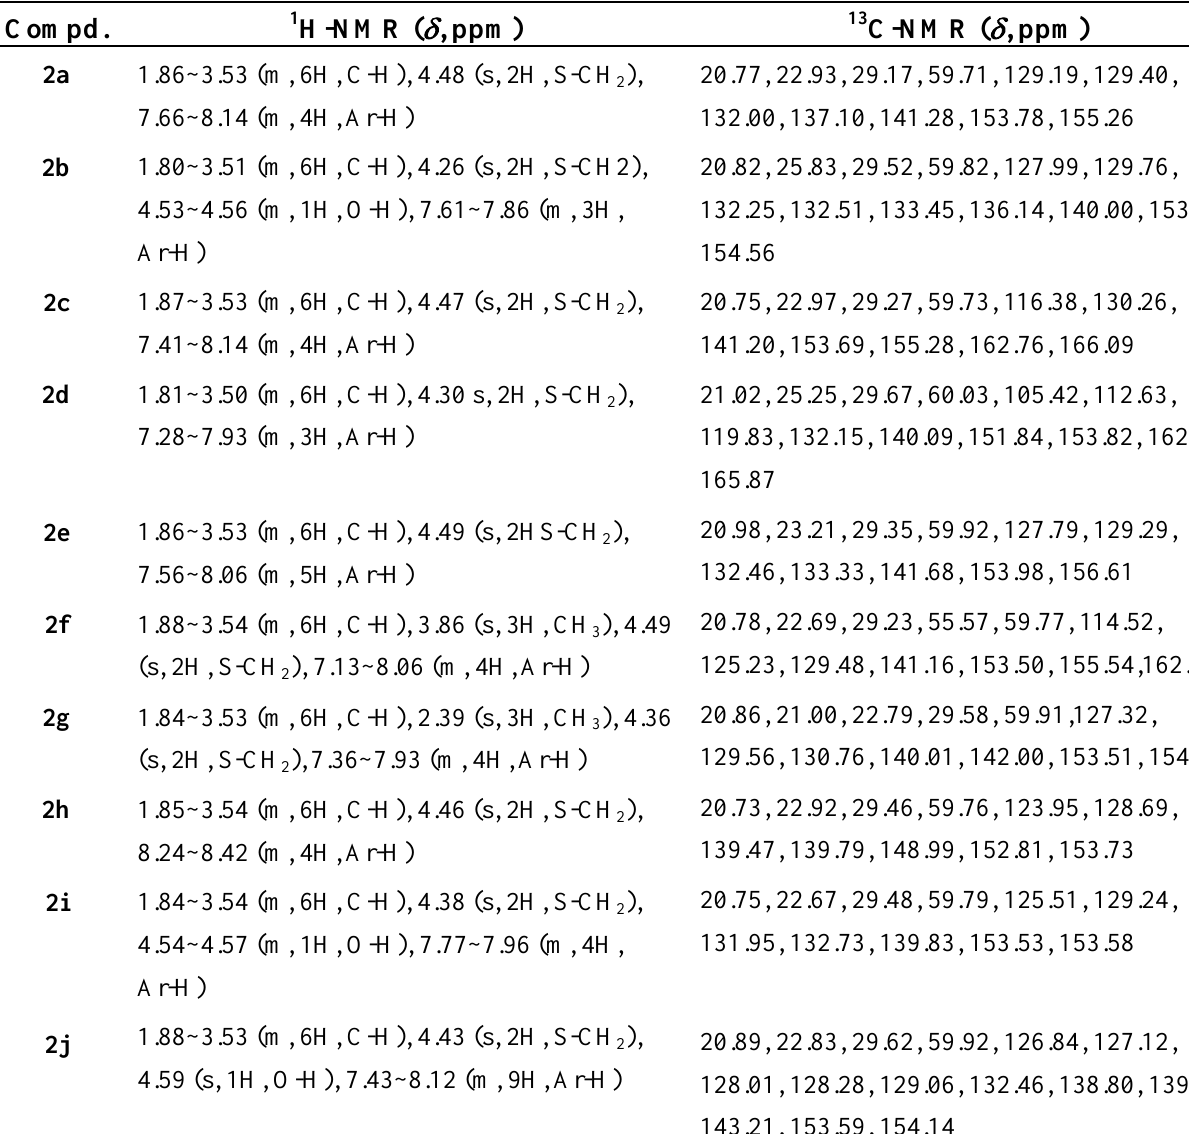
Table 4. NMR data of compounds 2a ~